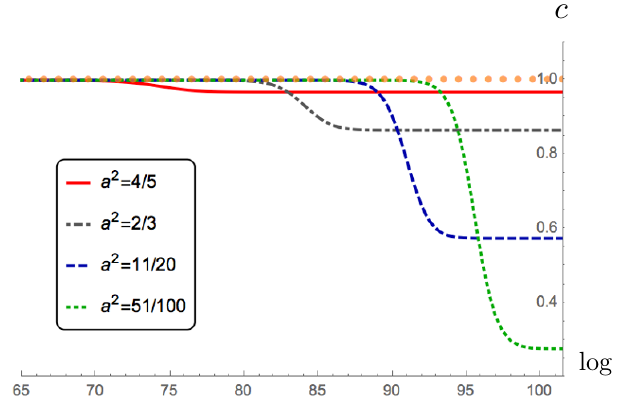
Figure 5 . (color online) The entropic c-function evaluated in the AdS uv (cid:13)ows with di(cid:11)erent values of a . The reference central charge of AdS uv orange circle line. The AdS ir large values of l